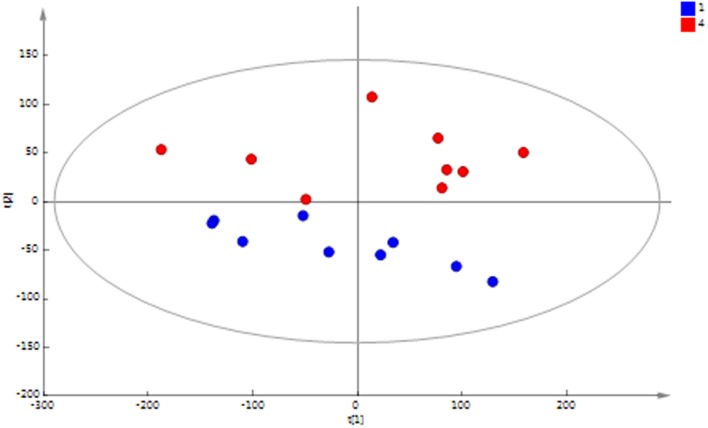
PCA scores plot of 1H NMR spectral data of anolyte from MFC1 (blue) and MFC4 (red). A clear separation between the initial and final MFCs in the cascade along the second principal component (PC2) is observed [R2X (PC1) = 57.2%; R2X(PC2) = 14.5%; Q2= 0.53].